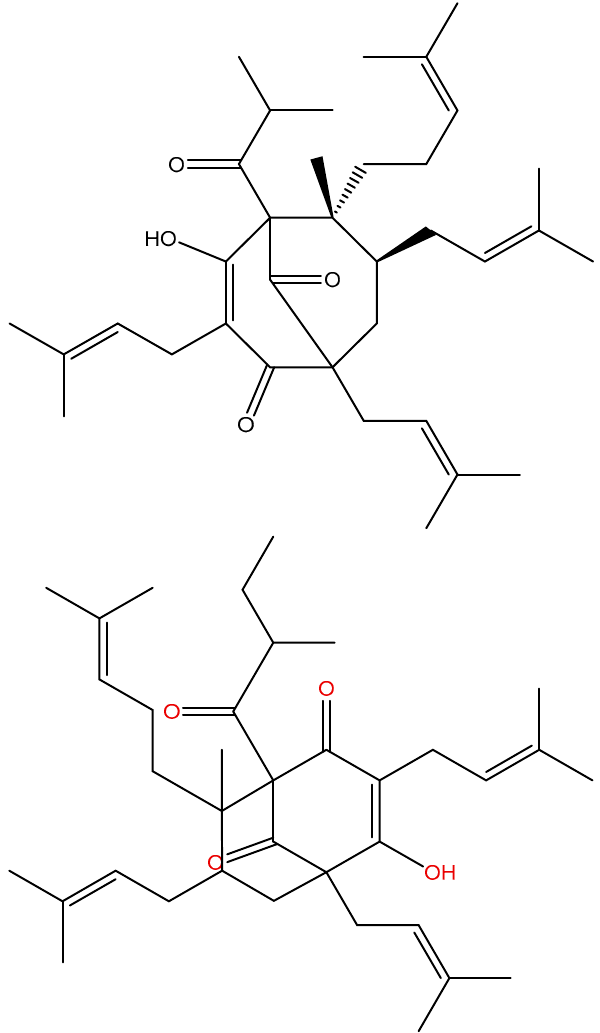
Figure 17. Hyperforin ( top ) and adhyperforin ( bottom ).